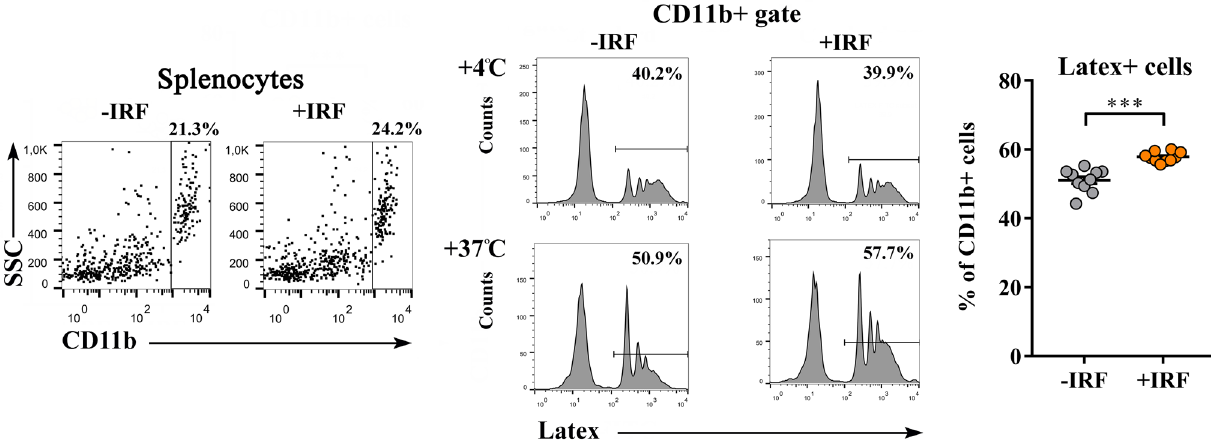
Figure 4. Influence of exposure to IR fibres on the phagocytic capacity of innate immune CD11b + cells from CIA-affected rats. Representative flow cytometry histograms show latex particle phagocytosis at + 4° C and + 37° C by CD11b + cells (gated as shown in representative flow cytometry dot plots generated using FlowJo Software for Windows, Version 7.8. FlowJo, LLC, Ashland, Oregon, USA; https ://www.flowj o.com.) from CIA rats housed in cages with IR fibre bedding (+IRF rats) and with standard wooden shaving bedding ( –IRF rats). Rats were transferred to cages with IR fibre bedding five days before immunization. Note that a significant difference between the groups was apparent only at 37° C. Scatter plot (created using GraphPad Prism version 7.00 for Windows, GraphPad Software, La Jolla, California, USA; https ://www.graph pad.com) indicates the percentage of phagocyting (latex +) cells among CD11b + cells from the spleen of +IRF and –IRF rats (see Material and Methods). Results are expressed as mean ± SEM. n = 10 rats/group. *** p ≤